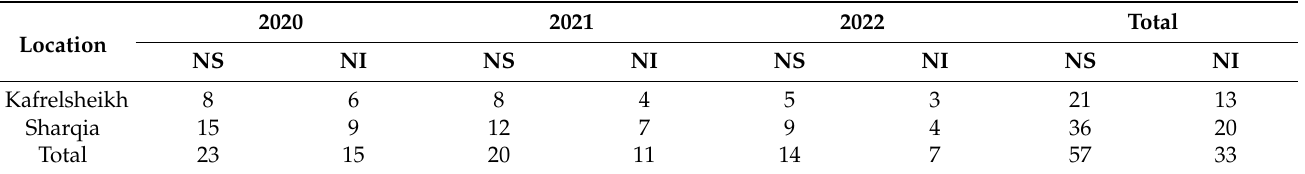
Table 5. Stem rust samples collected from Kafrelsheikh and Sharqia governorates during the three growing seasons.